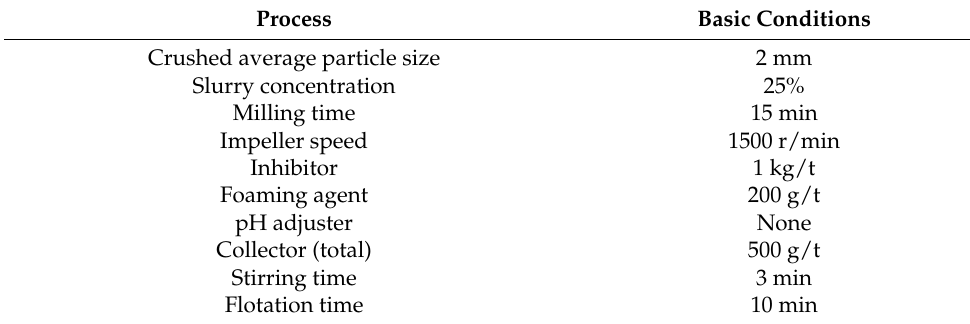
Table 5. Basic conditions for single factor flotation experimental